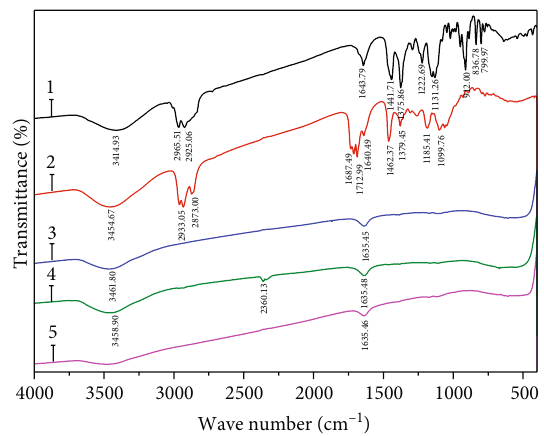
Figure 10: FT-IR spectrum of sphalerite treated with TA or TO (1: TA; 2: TO; 3: sphalerite; 4: sphalerite+TA; 5: sphalerite+TO).